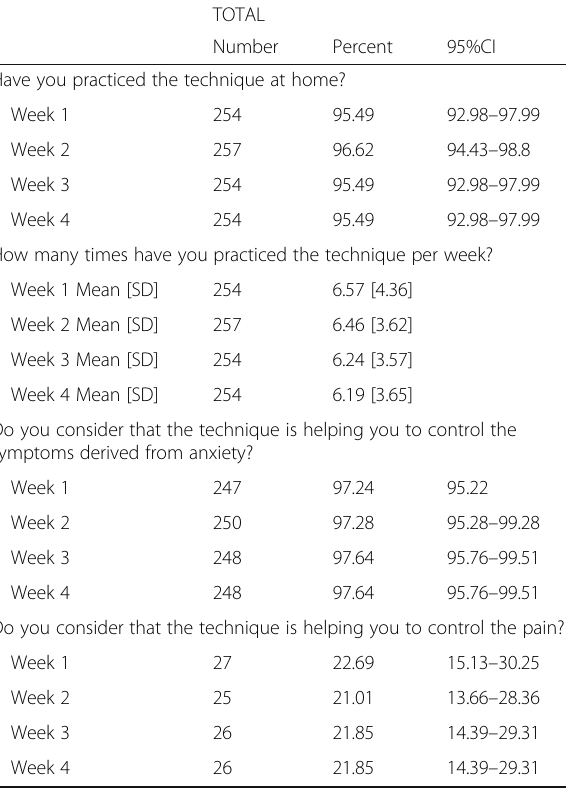
Table 4 Use of psychotropic and analgesic drugs after the Table 5 Effects of intervention on study participants